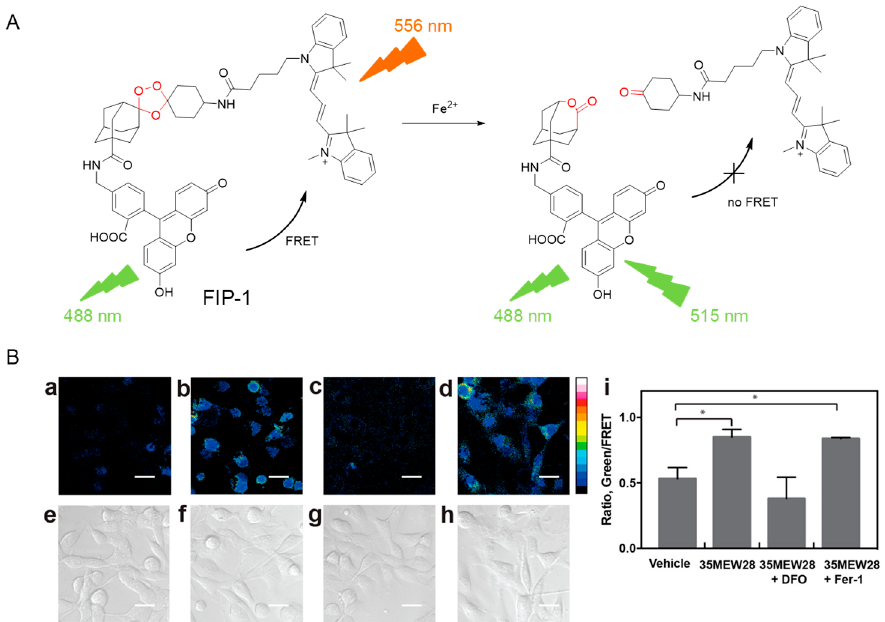
Figure 2. The FRET − based Fe 2+ probe FIP − 1 and its application in imaging of changes in labile iron pools during 35MEW28 − initiated ferroptosis of MD − AMB − 231 cells. ( A ) Response mechanism of FIP − 1 to Fe 2+ . ( B ) Fluorescence imaging of FIP − 1 in MDAMB − 231 cells treated with ( a ) vehicle, ( b ) 35MEW28, ( c ) 35MEW28 + DFO, and ( d ) 35MEW28 + Fer − 1. ( e – h ) Bright field images of ( a – d ). ( i ) Mean Green/FRET ratios of MDA − MB − 231 cells. Statistical significance was assessed by calculating p − values using one − way ANOVA with the Bonferroni correction in R, * p < 0.05. Reprinted/adapted with permission from Ref. [36]. Copyright 2016, American Chemical